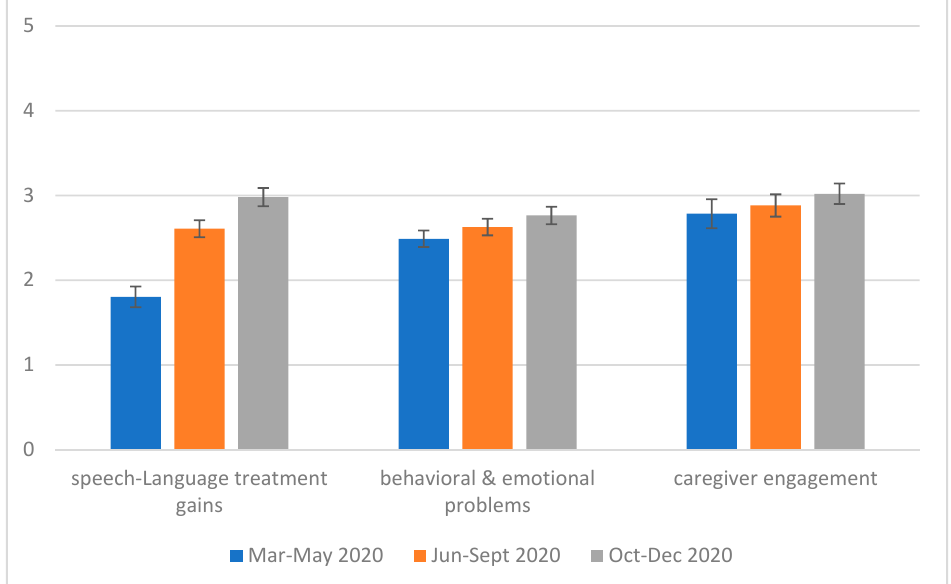
Figure 3. Longitudinal changes for speech–language treatment gains, behavioral and emotional problems, and caregiver engagement across the three periods during the pandemic in the December 2020 survey ( n = 51). Notes: SLPs rated the three aspects on a five-point scale: 1 = much less/worse than pre-pandemic level, 2 = less/worse than pre-pandemic level, 3 = similar to pre-pandemic level, 4 = more/better than pre-pandemic level, and 5 = much more/better than pre-pandemic level.